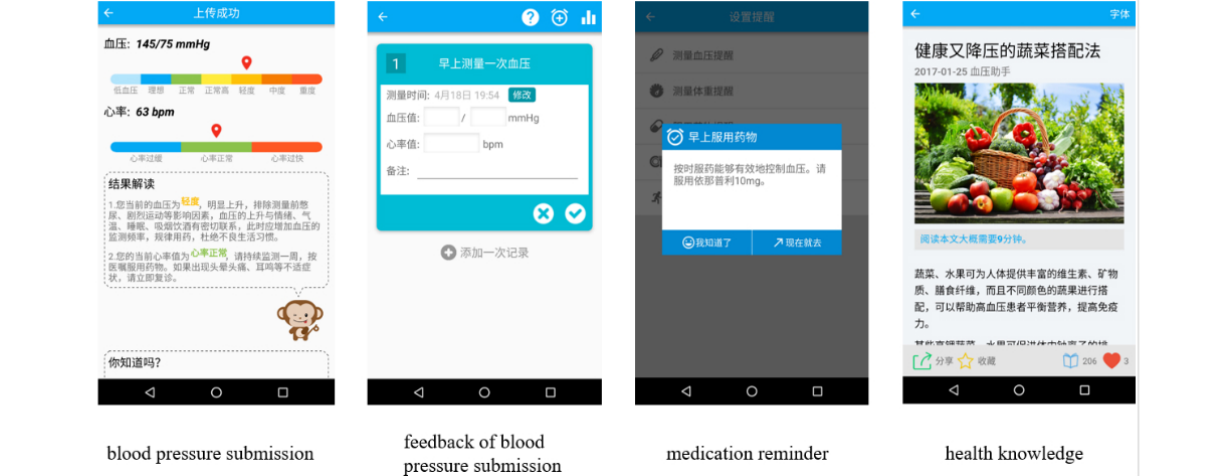
Figure 2. Screenshots of the smartphone-based Blood Pressure Assistant